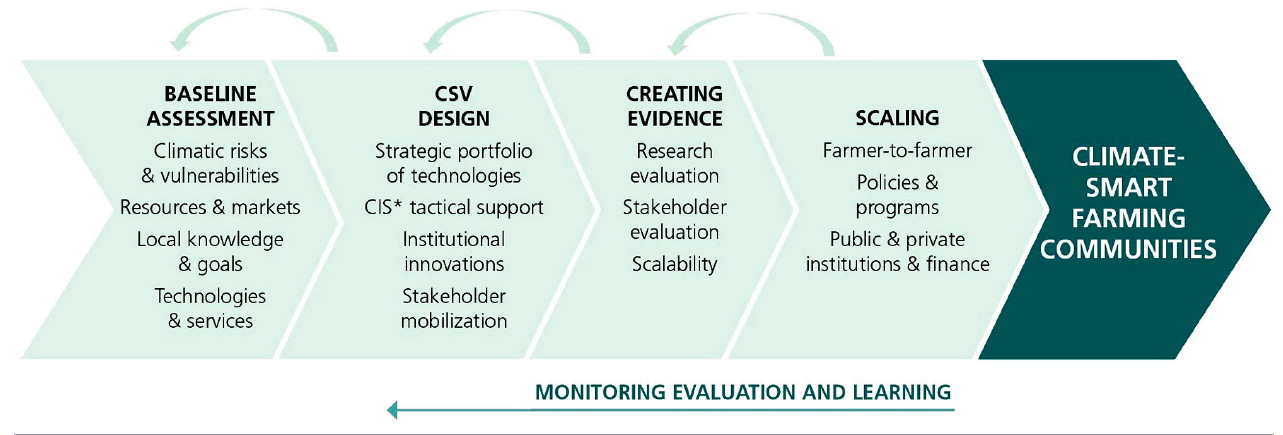
Fig. 2. Outline of the steps in a typical CSV AR4D site. Steps are based on stakeholder engagement and seldom follow a simple linear